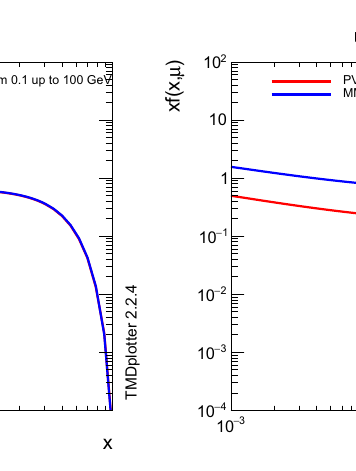
APDF2.0 [46]. (right): comparison of integrated distribution PV17 [47] with MMHT2014 [48]